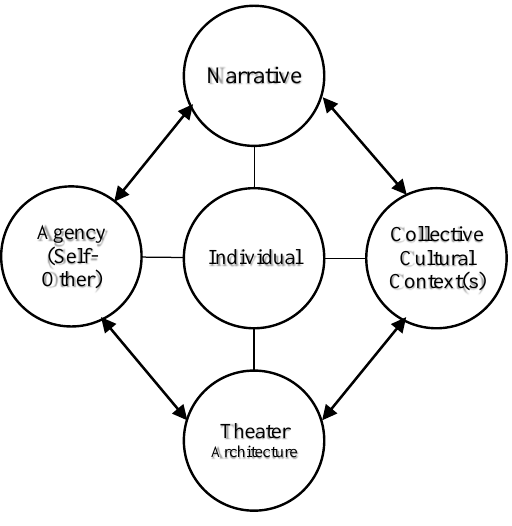
Figure 1. Individuation and Emergence in Community-Based Figure 1. – Individuation and Emergence in Community-Based Theater.